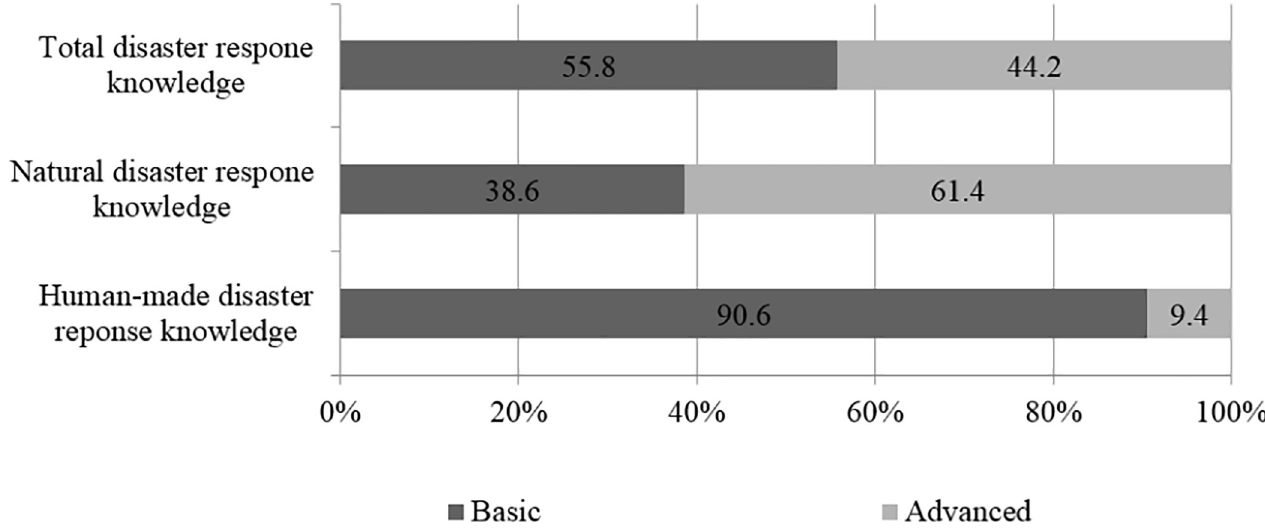
Fig 1. Status of residents’ disaster response knowledge in Beijing,